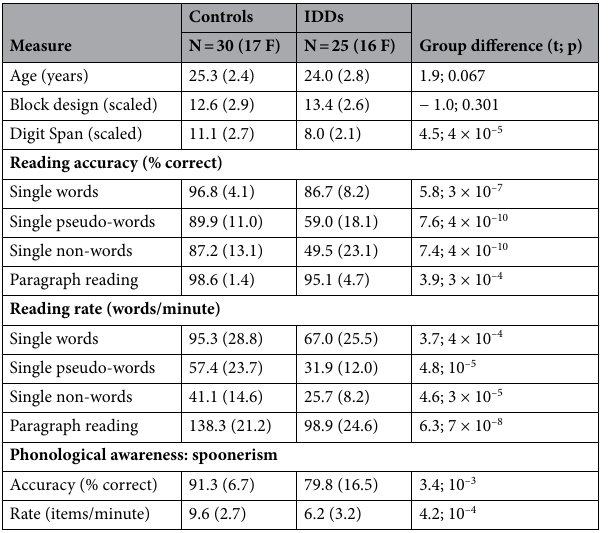
Table 2. Participant characteristics: general, reading, and phonological abilities. Means and SDs. F Female